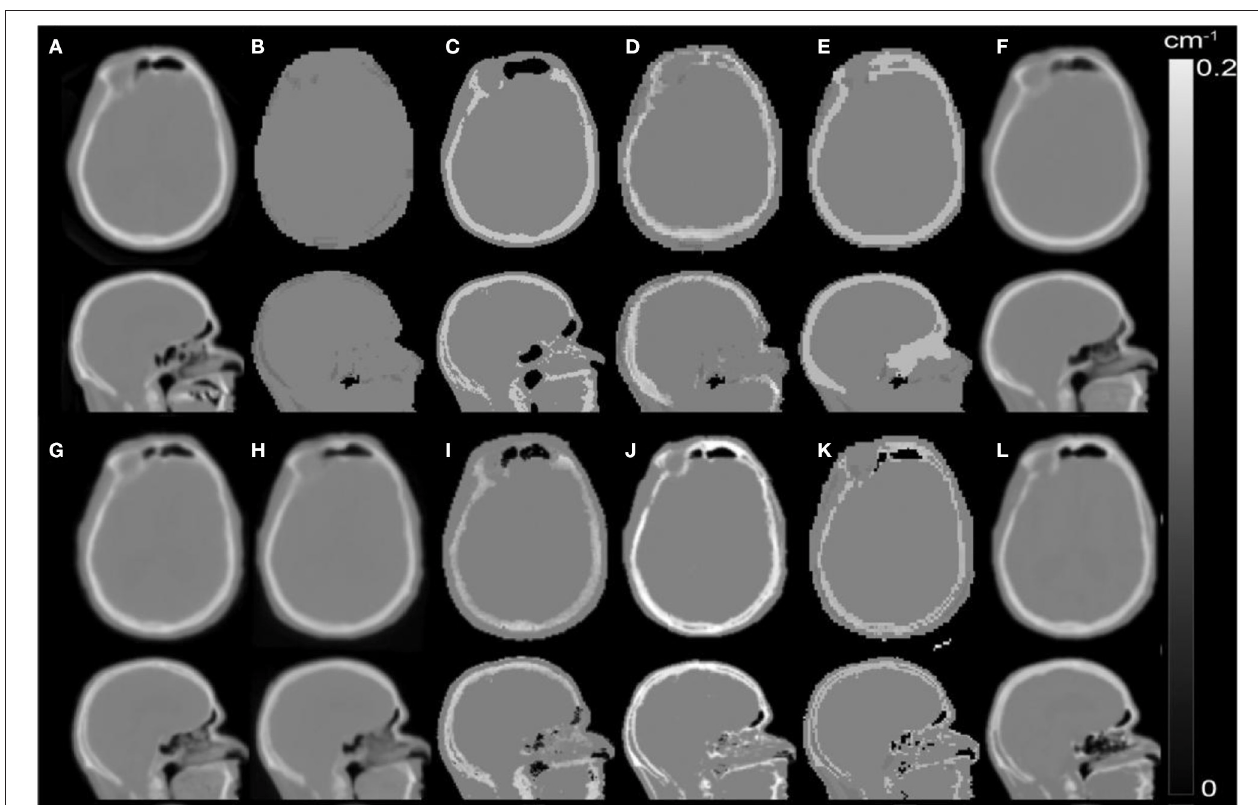
FIGURE 6 | Illustration of popular MR-based AC methods using the same axial slice of AC maps of a patient processed with different AC methods: (A) Reference CT-based AC; Standard methods: (B) standard DIXON-based MR-AC implemented in the Siemens mMR system (SW v. VB20), (C) UTE-based standard MR-AC for brain examinations implemented in the Siemens mMR system (SW v. VB20); Template-based methods: (D) Koesters et al. [208], (E) Anazodo et al. [209], (F) Izquierdo-Garcia et al. [210], (G) Burgos et al. [211], (H) Merida et al. [212]; MLAA-based methods: (I) Benoit et al. [213]; Segmentation-based methods: (J) Cabello et al. [ 214], (K) Juttukonda et al [215], (L) Ladefoged et al. [216]. Figure adapted from Ladefoged et al. [217] (Courtesy of Claes N. Ladefoged, Rigshospitalet Copenhagen, Denmark; Modified from the original image published under the creative commons license http://creativecommons.org/licenses/by-nc-nd/4.0/). Figure published with the permission of the copyright holders (Claes N.